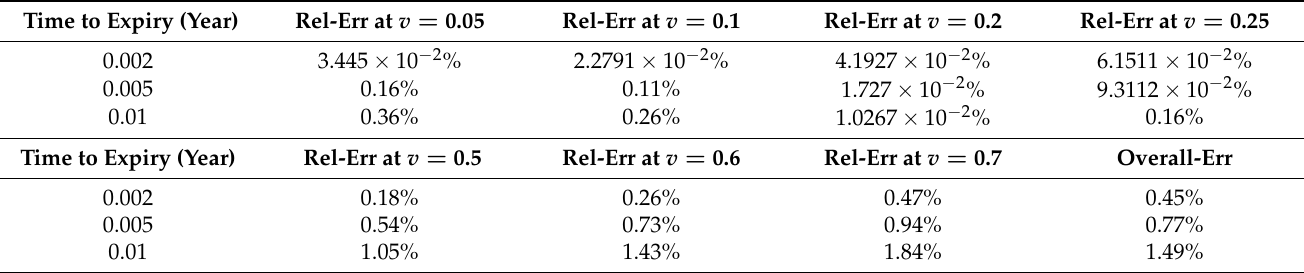
Table 1. Report on the relative error and the overall